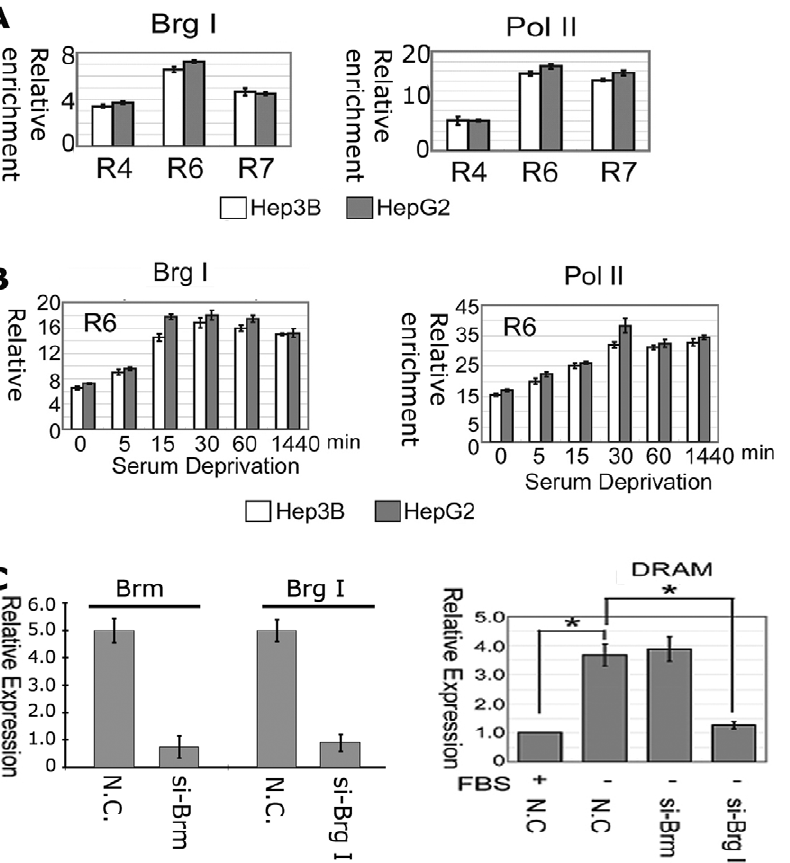
Figure 6. The chromatin remodeling factor Brg-1 is essential for serum starvation-induced DRAM expression. (A) Brg-1 is bound to the proximal region of the DRAM promoter. ChIP assays were performed in Hep3B and HepG2 cells. (B) Serum deprivation enhances Brg-1 and Pol II binding to the DRAM promoter locus. (C) Depletion of Brg-1 using specific targeting shRNA abolishes serum deprivation induced DRAM expression.